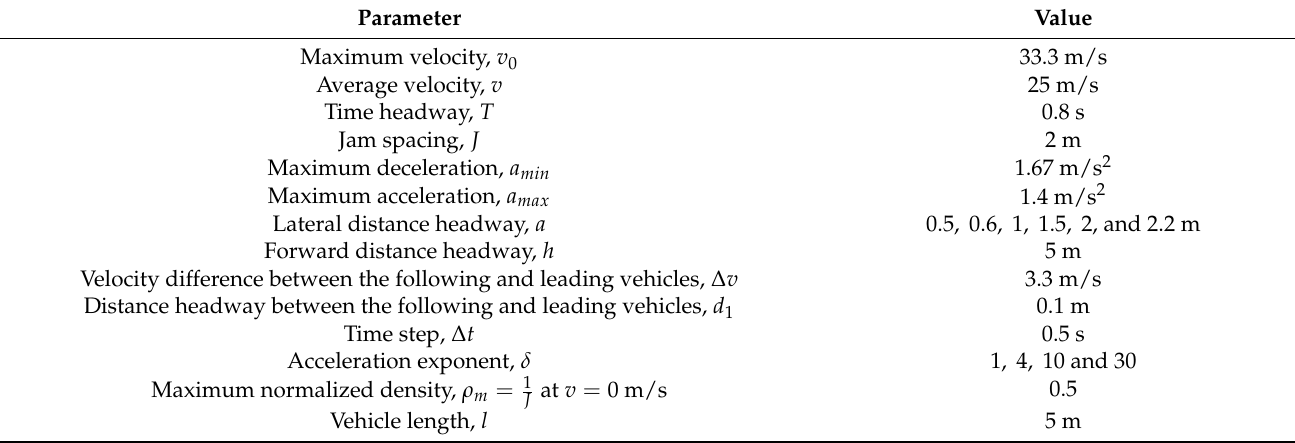
Table 2. Simulation